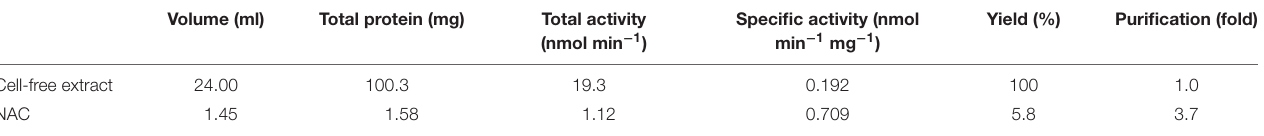
TABLE 1 | Purification of MopA-hp.